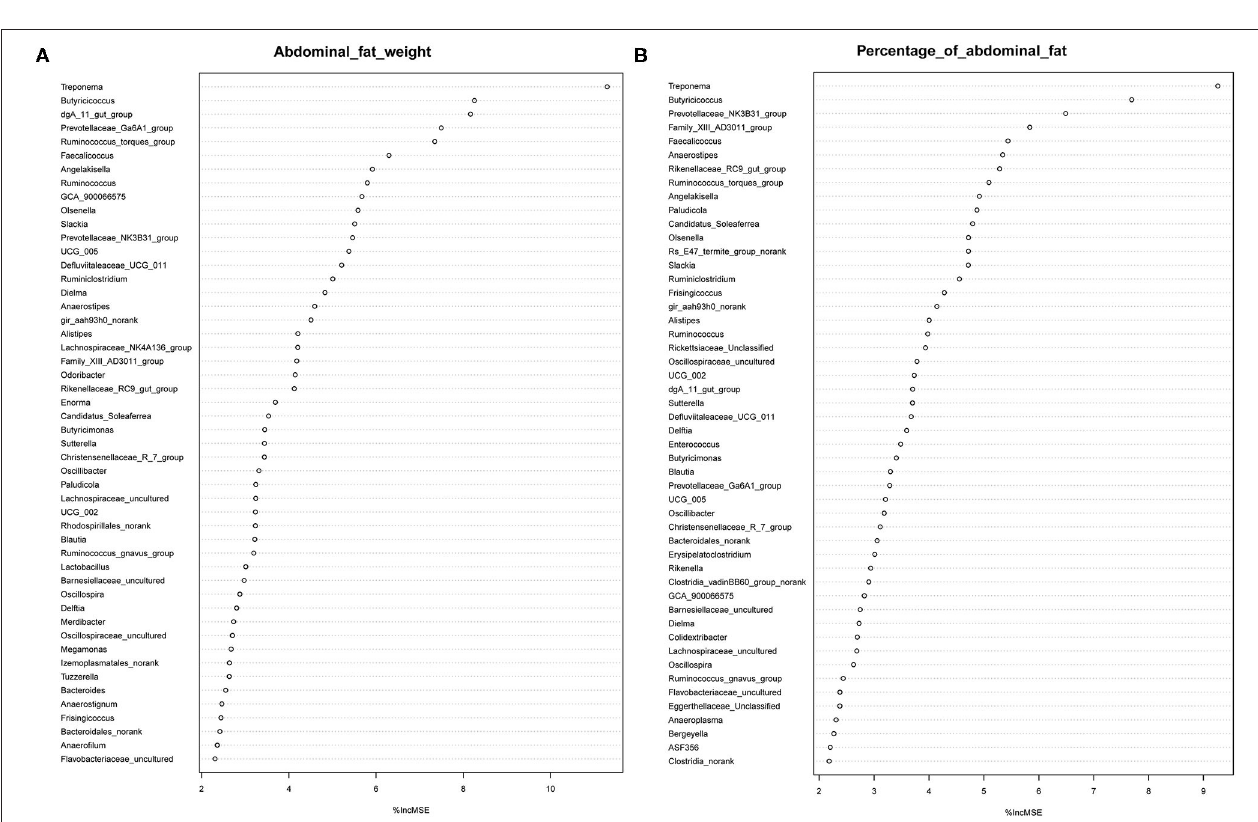
FIGURE 6 | Abdominal fat weight (A) and percentage of abdominal fat (B) related genus in the cecum of Muscovy ducks.